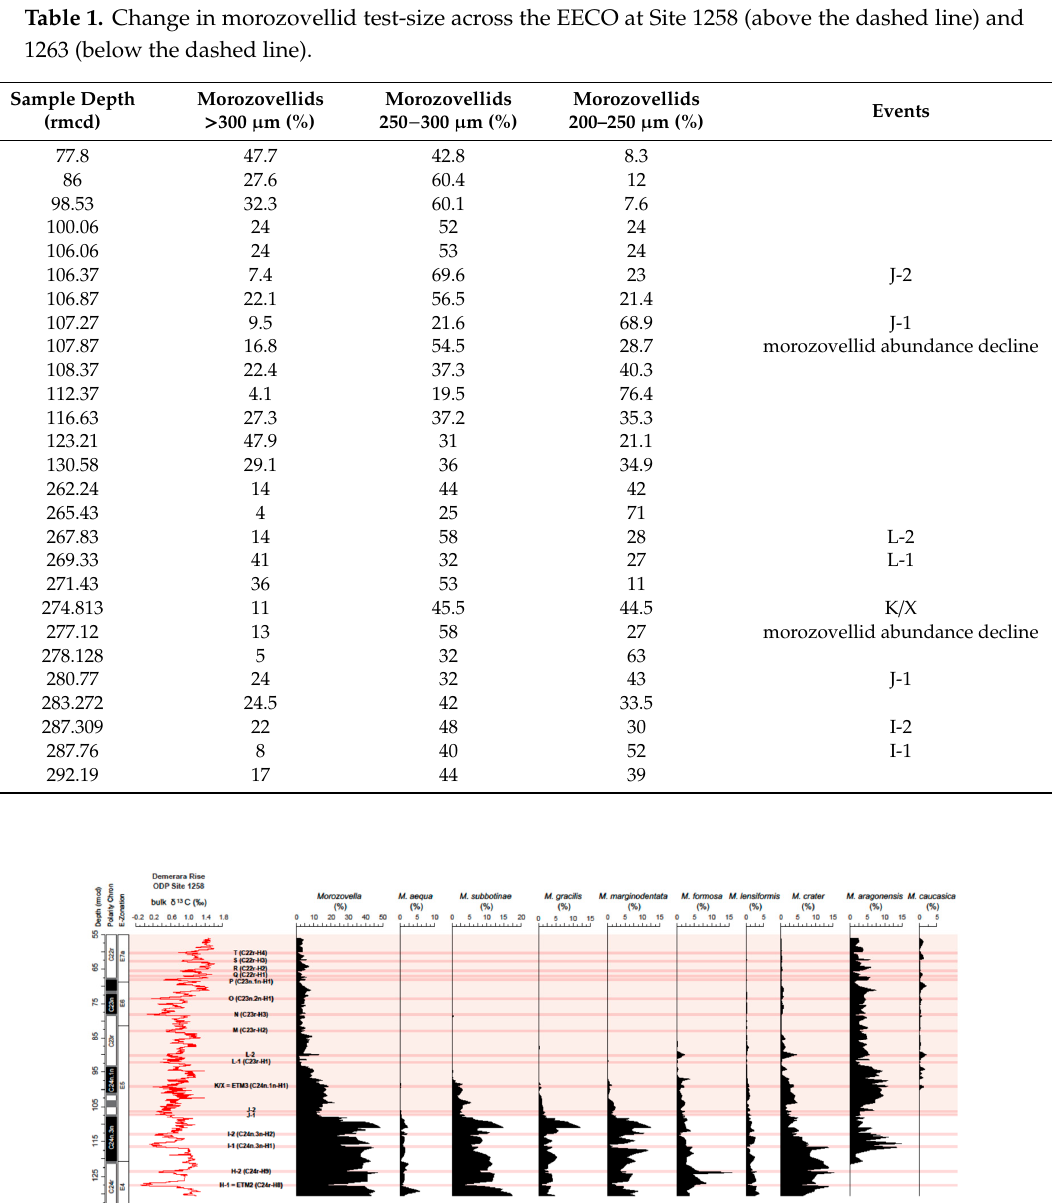
Table 1. Change in morozovellid test-size across the EECO at Site 1258 (above the dashed line) and 1263 (below the dashed line).